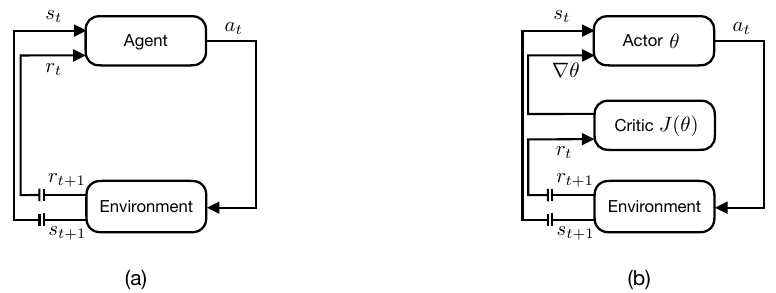
Figure 2. Fundamentals of reinforcement learning. ( a ) The state-action-reward-state-action feedback loop. The state, reward, and action at time t is given by s t , r t , and a t respectively, where a t = π ( s t ) and ) is the control policy. The agent optimizes its policy by observing and reacting to the environment. π ( · ( b ) The actor-critic training paradigm. The agent includes the actor and critic. The actor defines the control policy (the family of policies is parameterized by θ ). The critic evaluates the policy ( J ( θ ) is the ) ) based on feedback from the environment, and guides the actor to a better value of the policy π θ ( · θ policy (via the gradient ∇